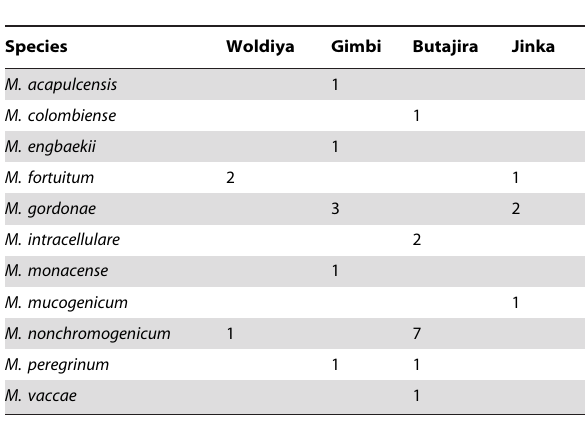
Table 3. Non-tuberculous mycobacteria isolated from cattle in